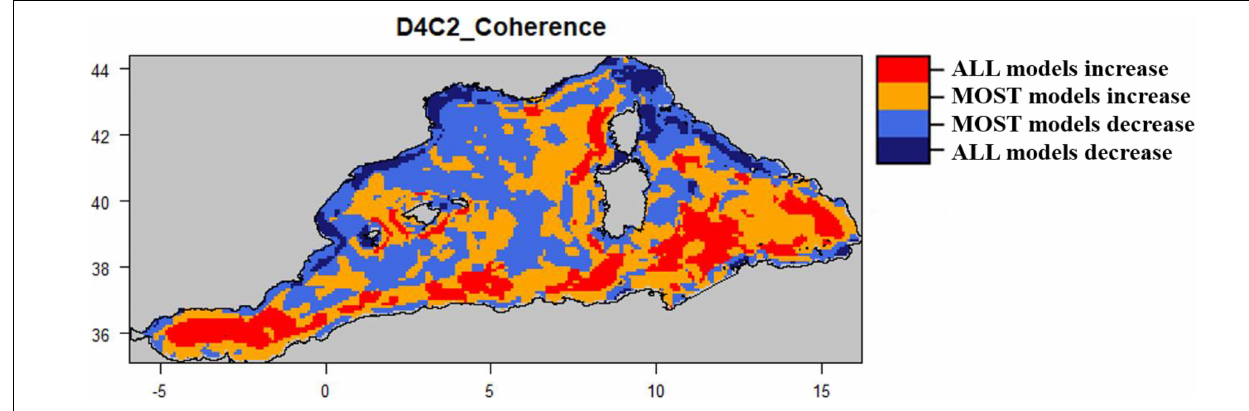
FIGURE 6 | Coherence map for Small pelagic fish biomass (D4C2) which shows where all or most models (2 out of three) agree on the relative change trend.